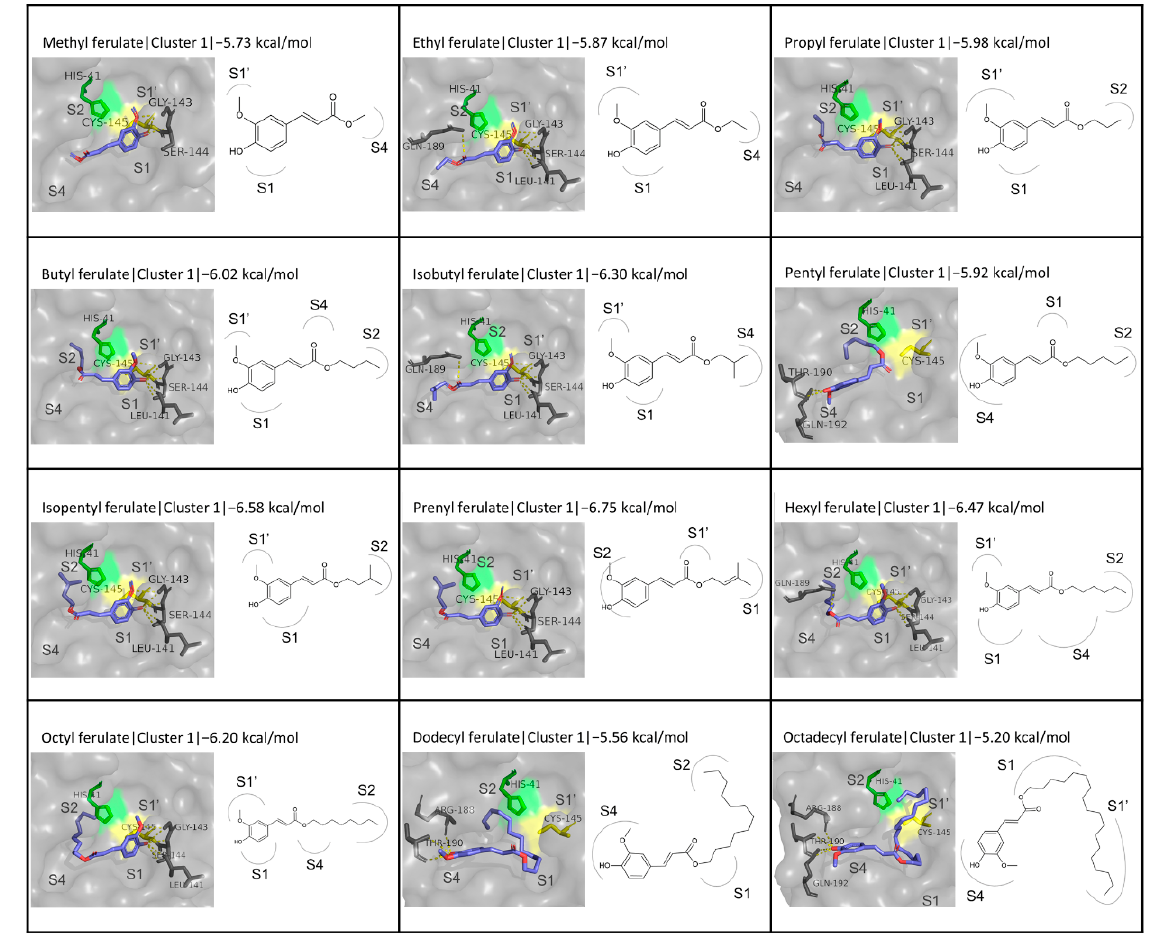
Figure 4. Structures and binding modes of alkyl and alkenyl FA esters in the active site of M pro .